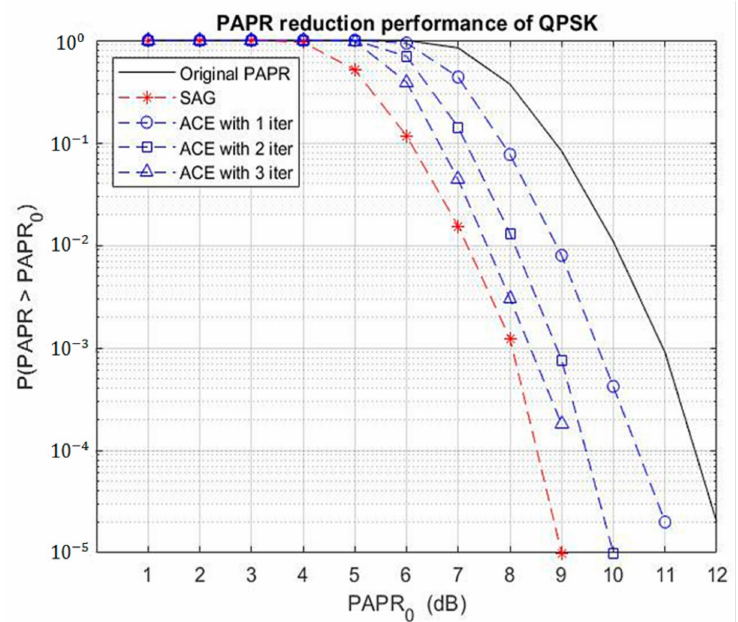
Figure 6. PAPR reduction performance comparisons of the QPSK–OFDM with the SAG and ACE method with one to three iterations.